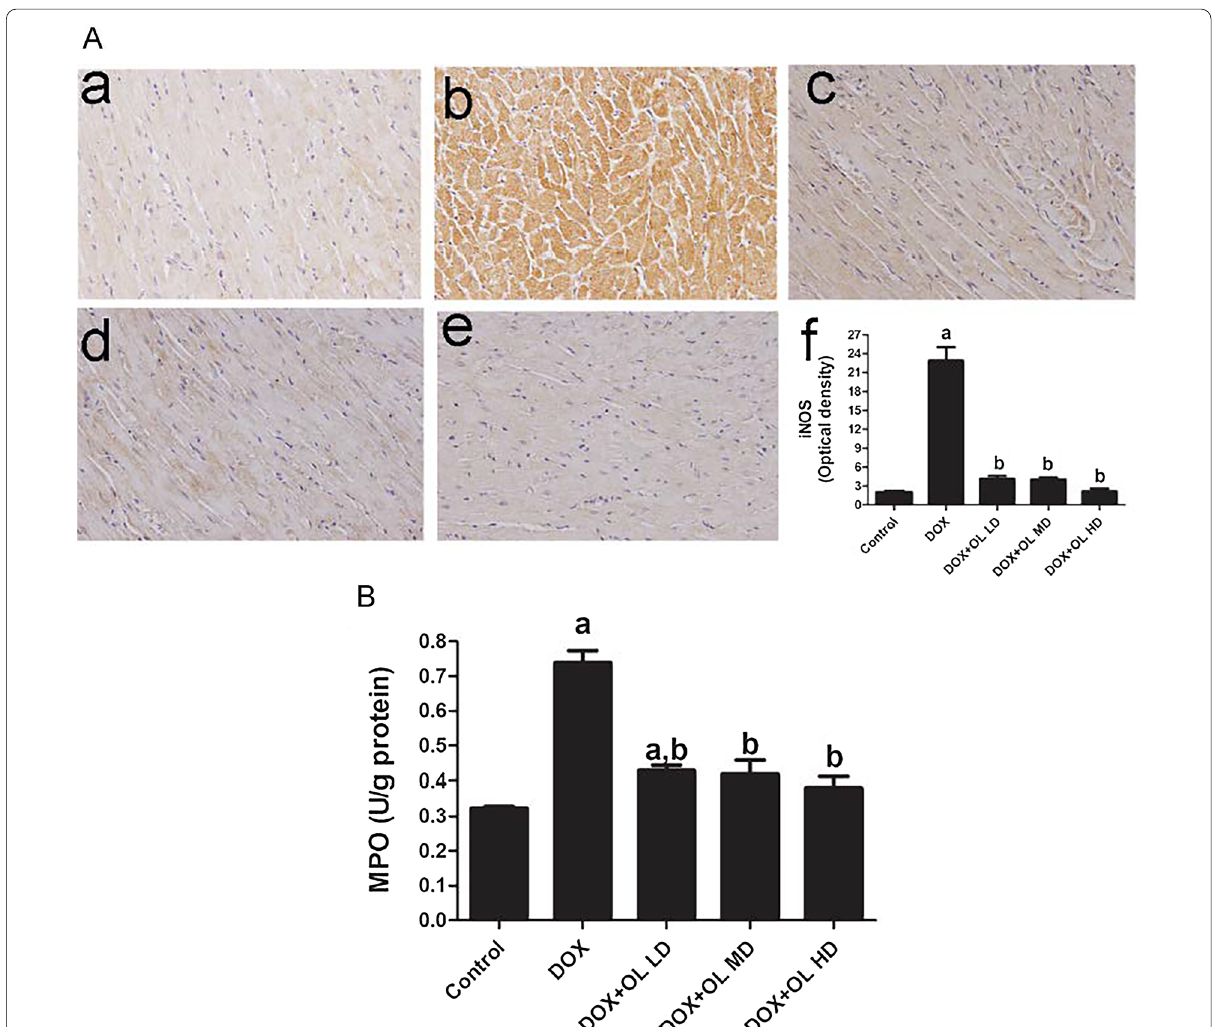
Fig. 3 A Representative photomicrographs of immunohistochemical analysis of iNOS of cardiac sections from the experimental groups (a) control, (b) DOX, (c) (DOX OL LD), (d) DOX OL MD, and (e) (DOX OL HD) treated groups (magnification 400). Brown staining indicates iNOS positive + + + × cells. F Quantitative image analysis for immunohistochemical staining expressed optical densities (OD) across 10 different fields from each rat section. B Cardiac MPO activity. Cardiac iNOS data are represented as mean SEM. for six animals in each group. Significance was determined by ± one-way analysis of variance followed by Dennett’s t-test: a P < 0.05 vs. control group, b P < 0.05 vs. DOX group. 400 ×